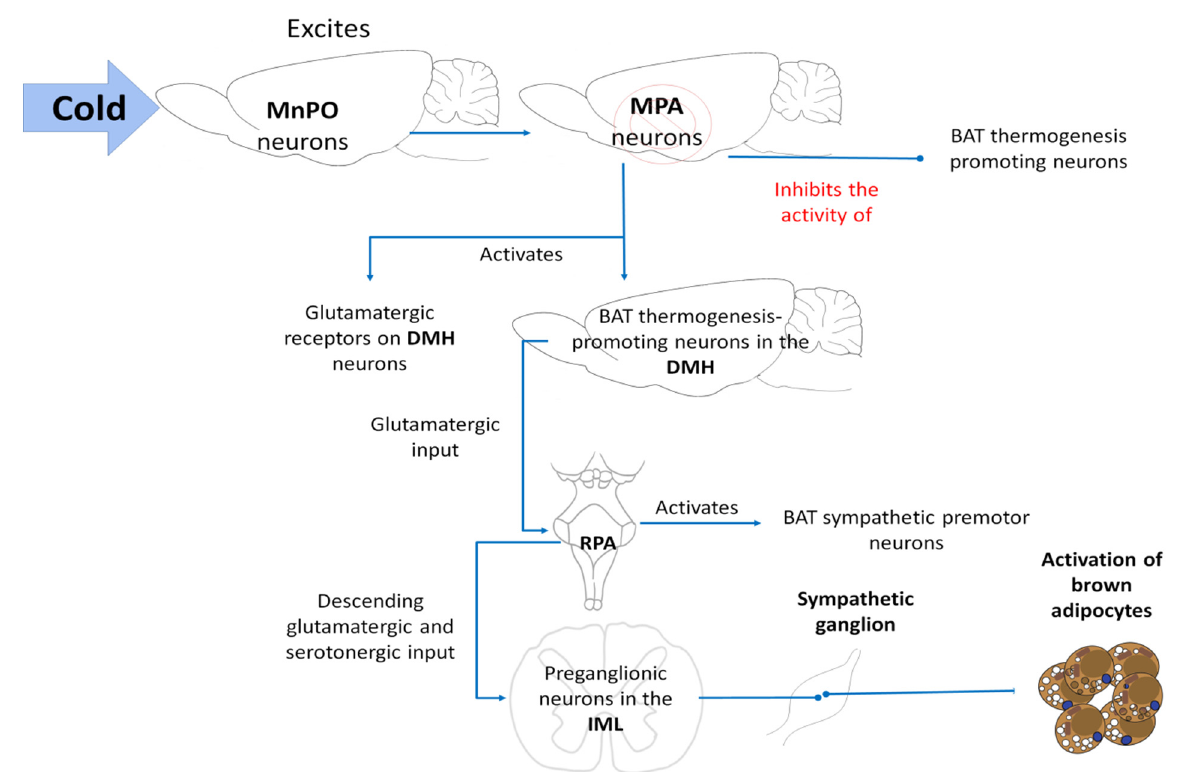
Figure 8. Neurophysiological mechanism for developing the BAT thermogenesis response. Detection of cold excites the neurons of the median preoptic nucleus (MnPO), which inhibits the activity of a group of neurons in the medial preoptic area (MPA) whose function is to suppress the activity of brown adipose tissue (BAT) thermogenesis-promoting neurons. The inhibition of said neurons and excitation of the glutamatergic receptors of the neurons in the dorsomedial hypothalamic nucleus (DMH) activate the BAT thermogenesis-promoting neurons in that structure. These neurons send a glutamatergic signal that activates the BAT sympathetic premotor neurons in the raphe pallidus area (RPA), increasing the descending glutamatergic and serotonergic input to the intermediolateral cell column (IML). These are the substances that trigger BAT activation.